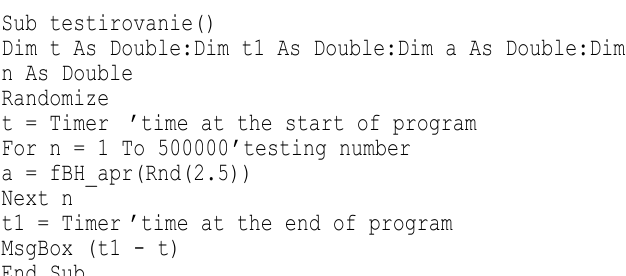
Fig. 10. Approximation with hyperbolic sine